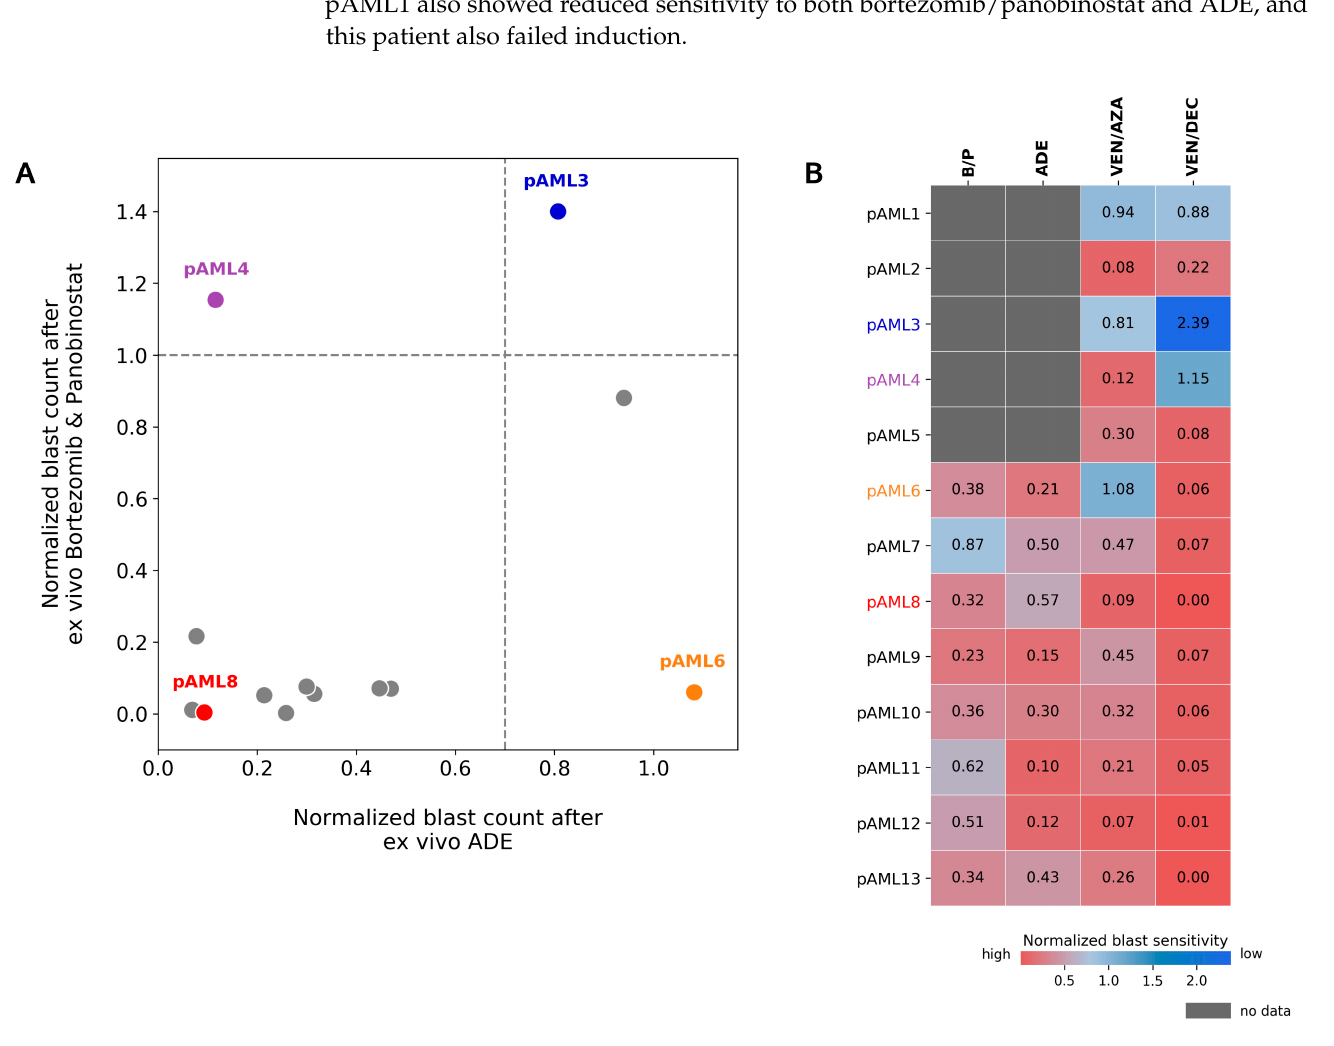
Figure 5. Differential response to ADE and Bortezomib/Panobinostat is observed ex vivo. ( A ) Comparison of normalized blast counts between ADE and bortezomib/panobinostat (B/P) in 13 diagnostic samples from patients with de novo AML. Dashed lines indicate cutoffs for high sensitivity (DSP <1.0 for B/P; DSP <0.7 for ADE). DSP values >1.4 are shown at 1.4. ( B ) Normalized blast counts for B/P, ADE, VEN/AZA (venetoclax/azacitidine), and VEN/DAC (venetoclax/decitabine) on a graded color-scale for high sensitivity (red) and low sensitivity (blue). Grey boxes indicate no data. Patients pAML3 (blue), pAML4 (purple), pAML6 (orange), and pAML8 (red) are labeled in the indicated colors.